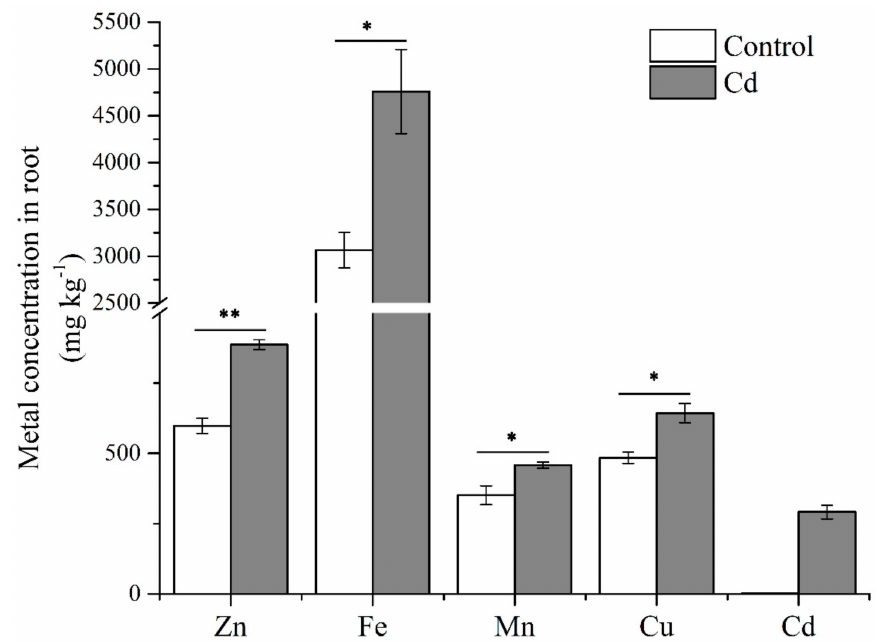
Figure 1. Metal concentrations of Italian ryegrass roots. Data are means ± SE (n = 3). Asterisks indicate significant di ff erences (* p < 0.05 and ** p < 0.01 by Duncan’s